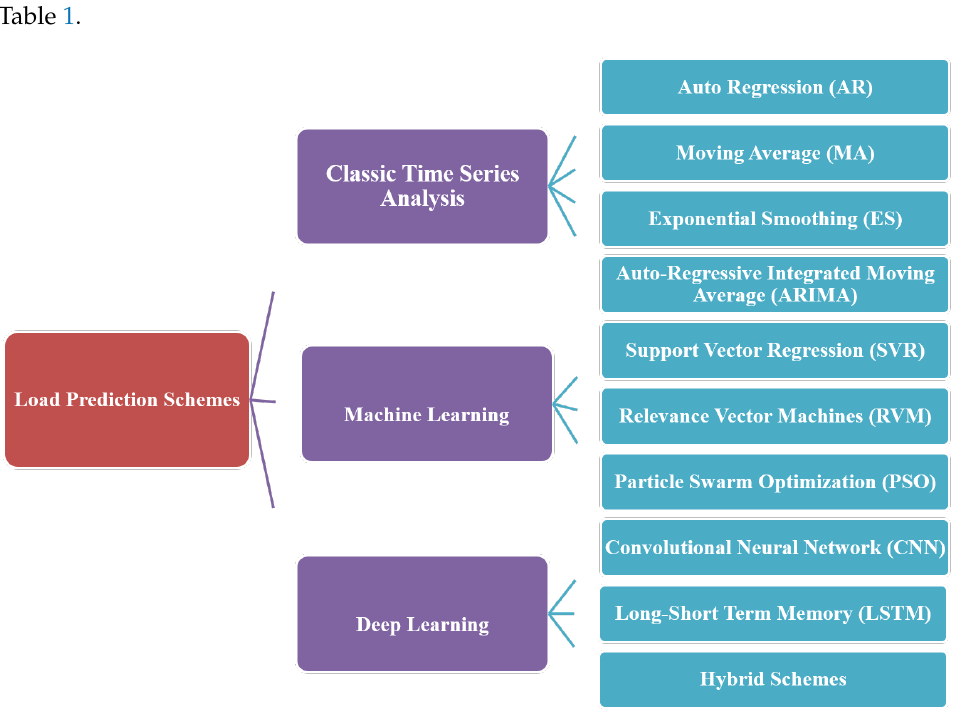
Figure 4. Taxonomy of load prediction